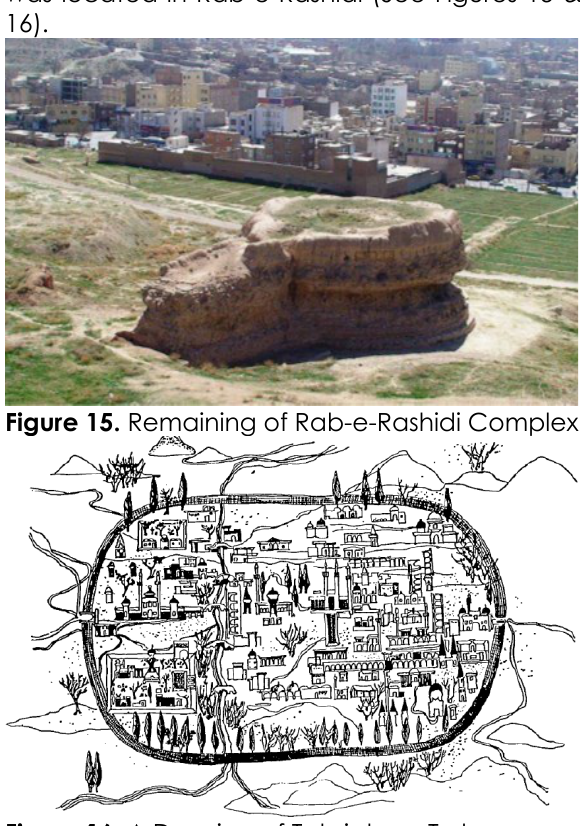
Figure 16. A Drawing of Tabriz by a Turk Traveler, 14 th Century A.D. Source: DHUD, 1992 (Azimi, 1995, p.